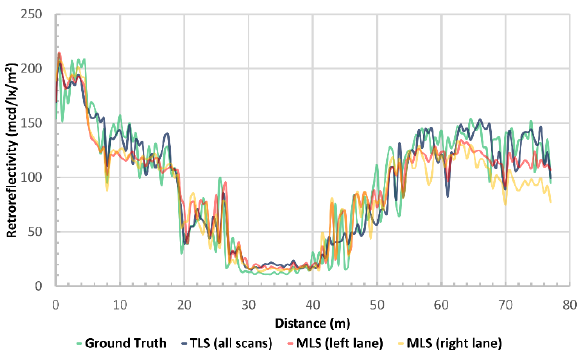
Figure 10. Comparison between retroreflectometer readings, and retroreflectivity estimation from TLS scans and MLS